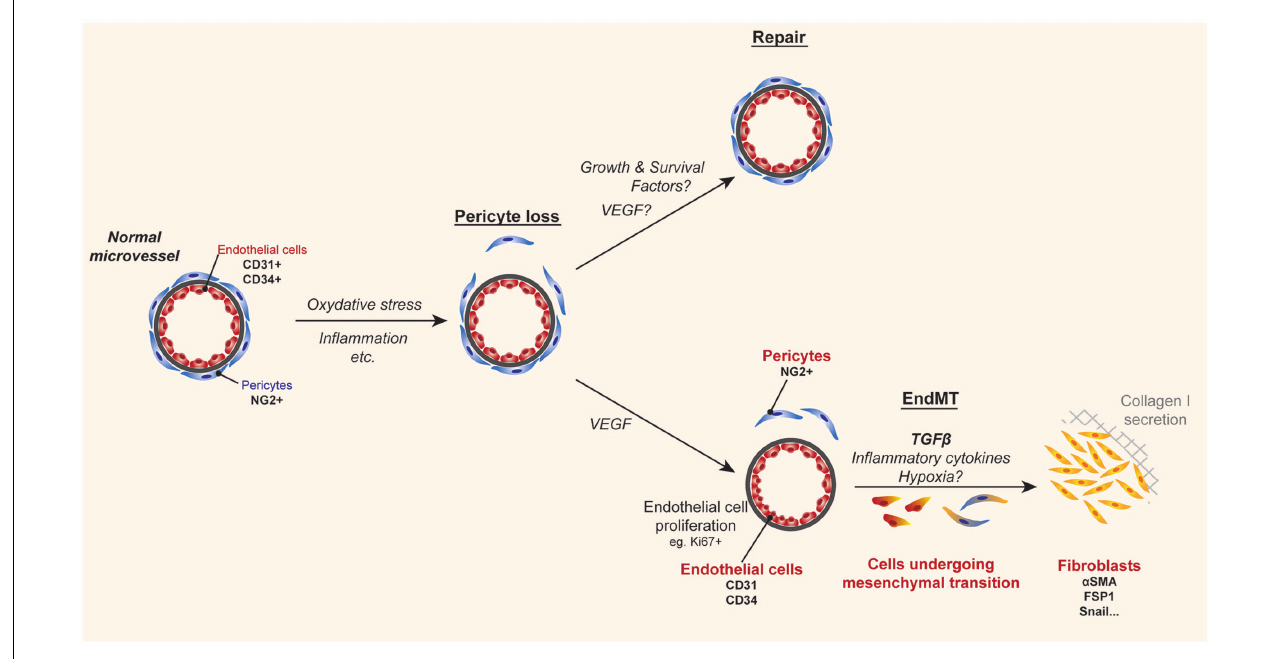
endothelial-to-mesenchymal transition (EndMT), where endothelial cells become denuded from their basement membrane and migrate along with pericytes into the surrounding tissue. Although still under debate, it is reported that the presence ofTGF β , inflammatory cytokines, and hypoxia enables dissociated pericytes and/or endothelial cells to dedifferentiate into collagen-secreting fibroblasts, which in turn results in fibrosis and